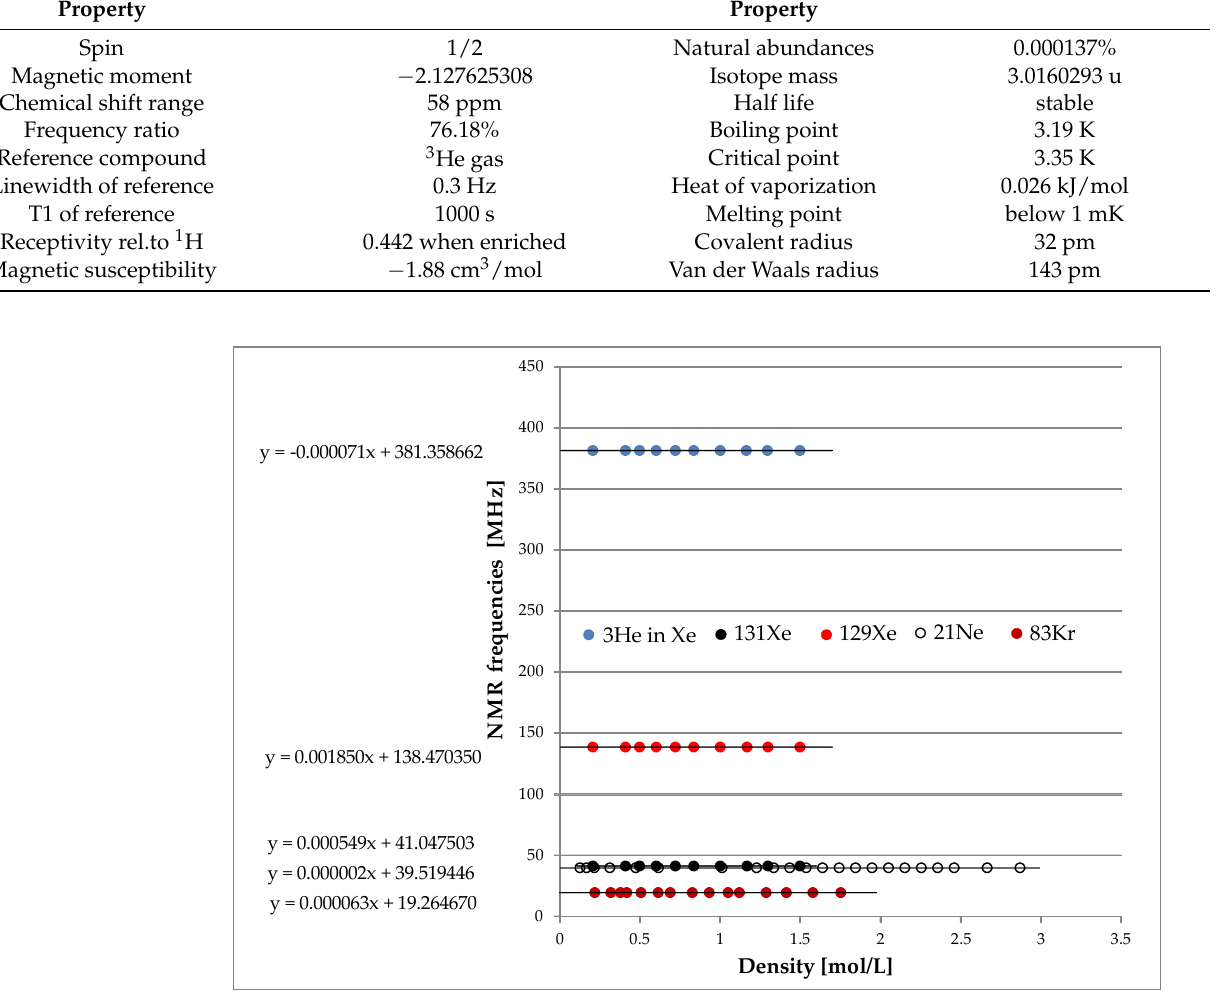
Table 1. Physical and magnetic properties of 3 He atoms and nuclei.